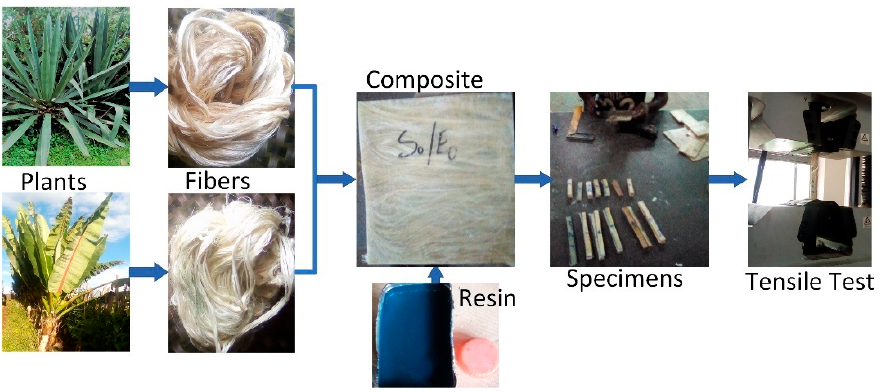
Figure 1. The composite fabrication process flow